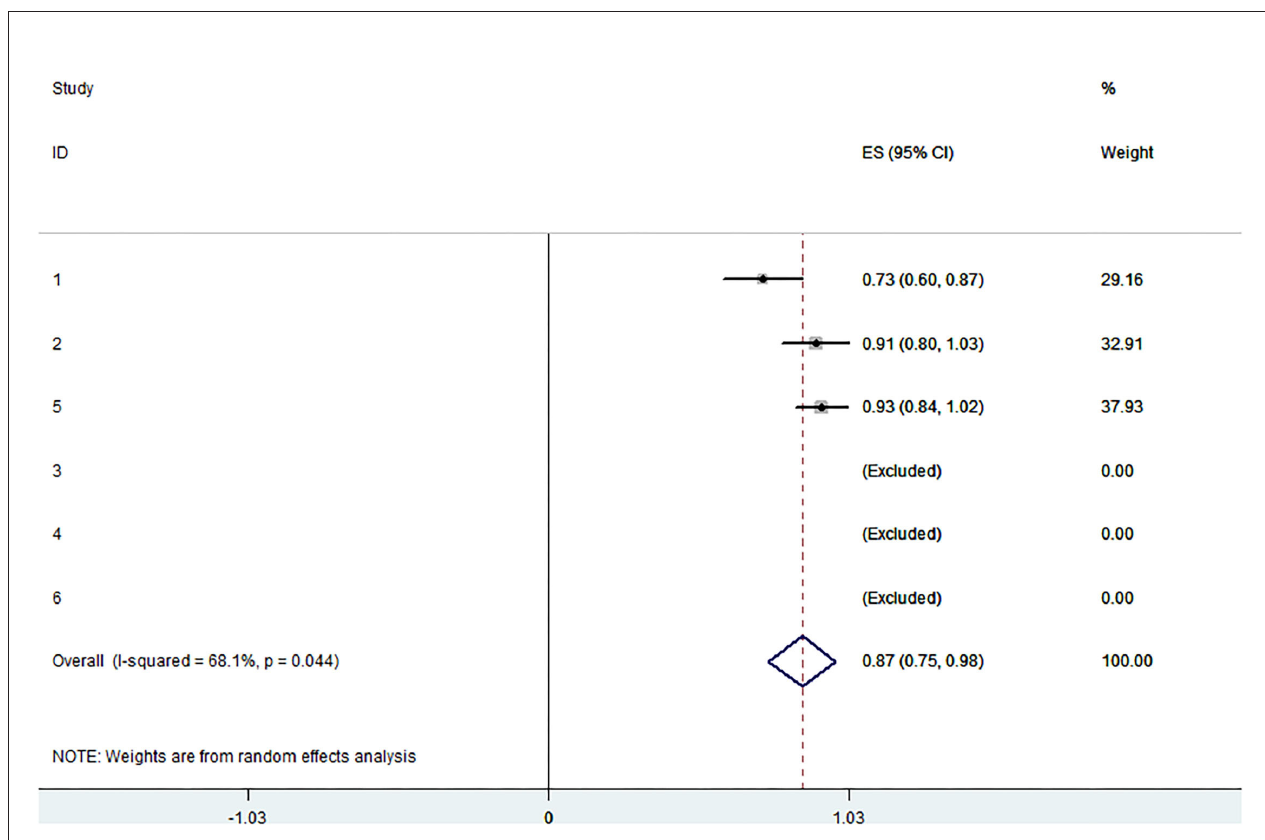
FIGURE 4 | Forest plot presenting the meta-analysis of technical success rate. CI, Confidence intervals; ES, Effect